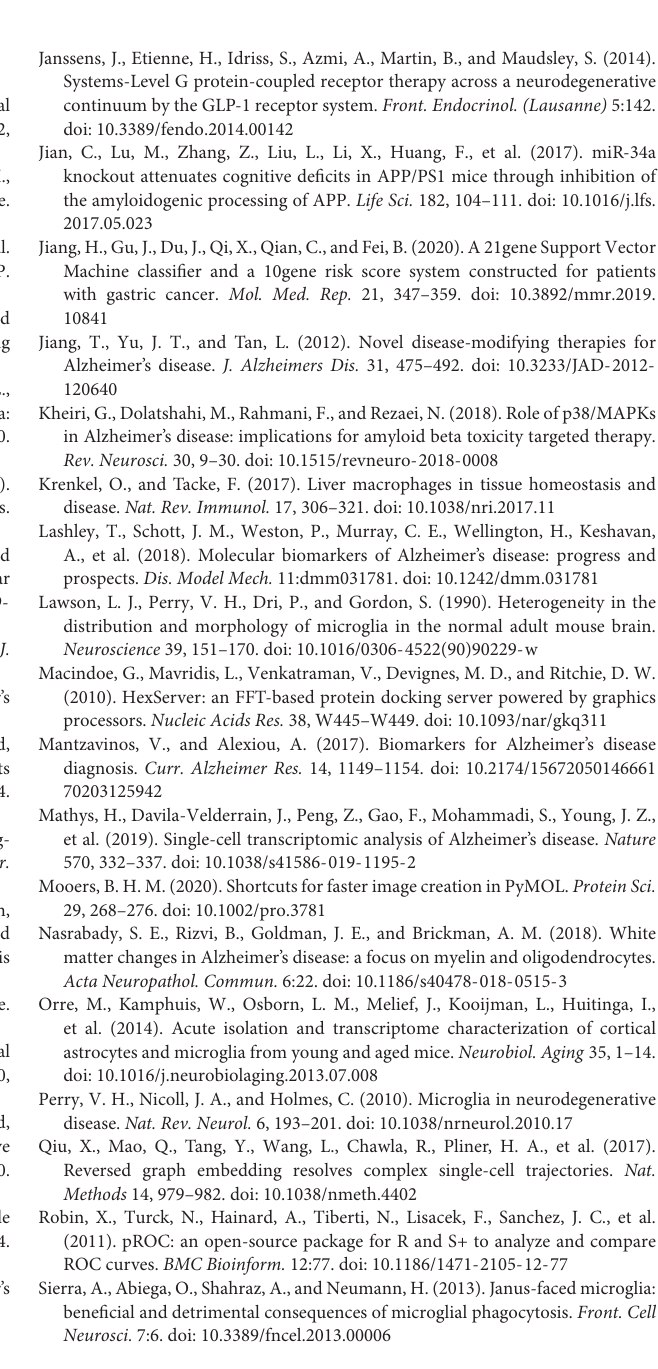
Supplementary Figure 1 | Evolution of expression dysregulation in relevant cell types during the course of AD. (A) T-distribution stochastic neighbor embedding (T-SNE) plot of inhibitory neurons and astrocytes, showing nine clusters. The bar chart shows the abundance of cell subsets in individuals showing strong or no/weak AD pathology. (B) Pseudotime of inhibitory neurons and astrocytes. Darker color indicates longer pseudotime. (C) Distribution of cells in different clusters in the trajectories of inhibitory neurons and astrocytes. (D) Expression distribution and heat map of genes as a function of pseudotime. Genes showing similar expression trends fell into distinct